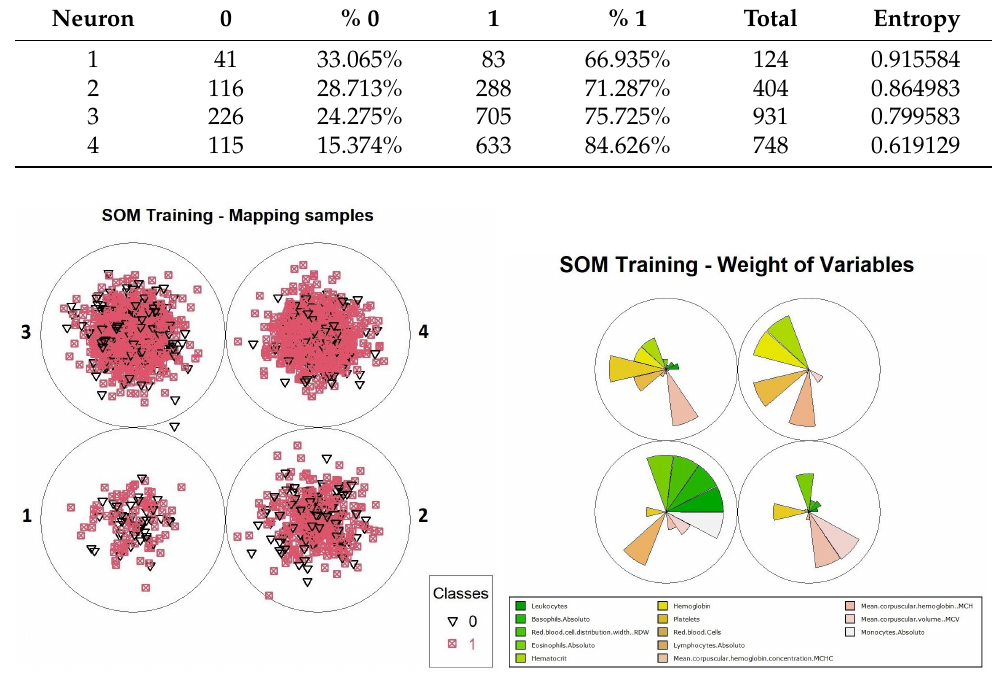
Figure 15. Distribution objects and weights per neuron, level 1 TESSOM